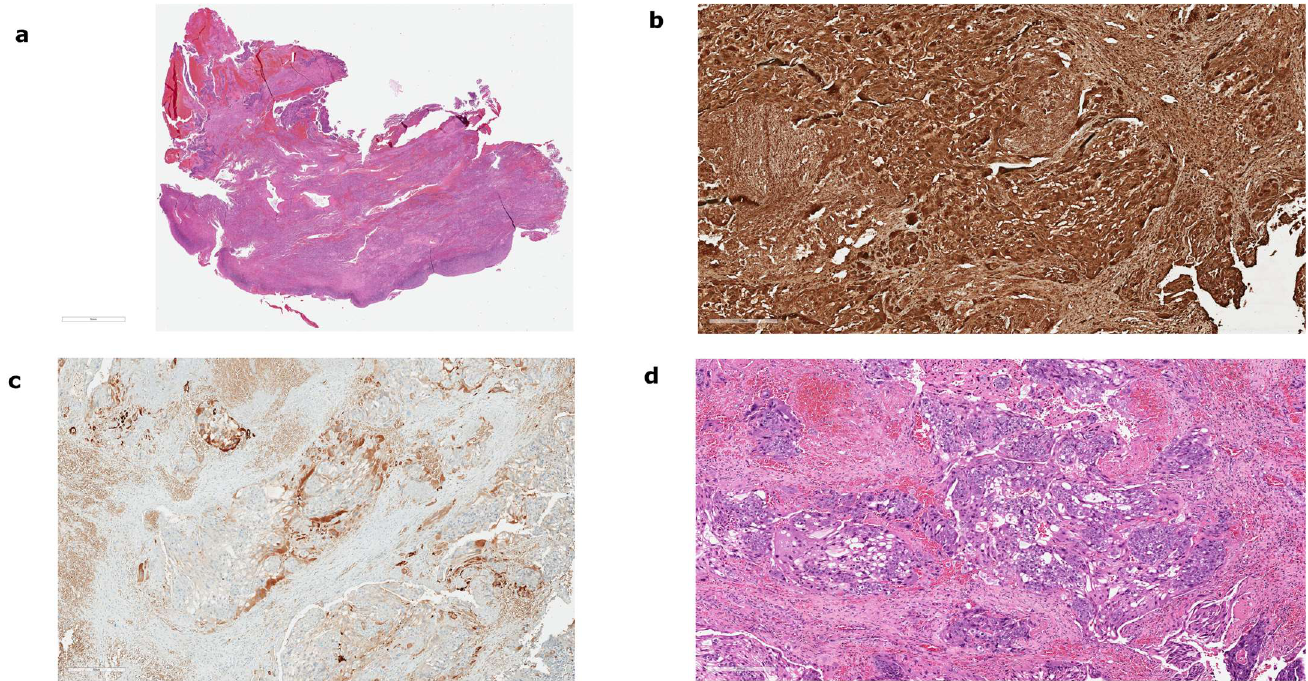
Figure 1. Histopathological features of the gestational choriocarcinoma. ( a ) Microscopic appearance of the ovary shows infiltration with pure gestational choriocarcinoma with widespread necrosis (H&E). ( b ) The tumor was positive for b-human chorionic gonadothropin., which is relatively specific for choriocarcinoma. ( c ) Positive inhibin stain indicates the presence of syncytiotrophoblast. ( d ) Intermediate magnification micrograph of choriocarcinoma (H&E). Choriocarcinomas consist of two cell populations: cytotrophoblast with pale/clear cytoplasm and syncytiotrophoblast with hyperchromatic cytoplasm and typically multinucleated cells.